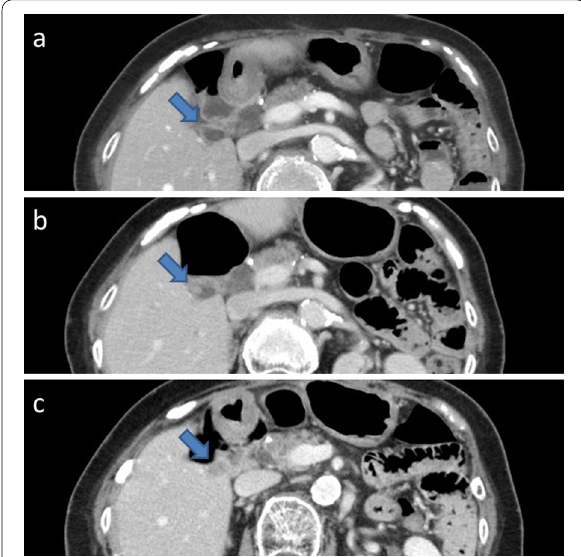
Fig. 2 Contrast-enhanced computed tomography (CECT) findings. a Preoperative CECT for sigmoid colon cancer. The cystic remnant gallbladder without a nodule is visible (arrow). b CECT performed 6 months after the colon surgery. A 5-mm small nodule is visible in the remnant gallbladder (arrow). c CECT performed 9 months after the colon surgery. A 10-mm enhanced nodule is visible in the remnant gallbladder